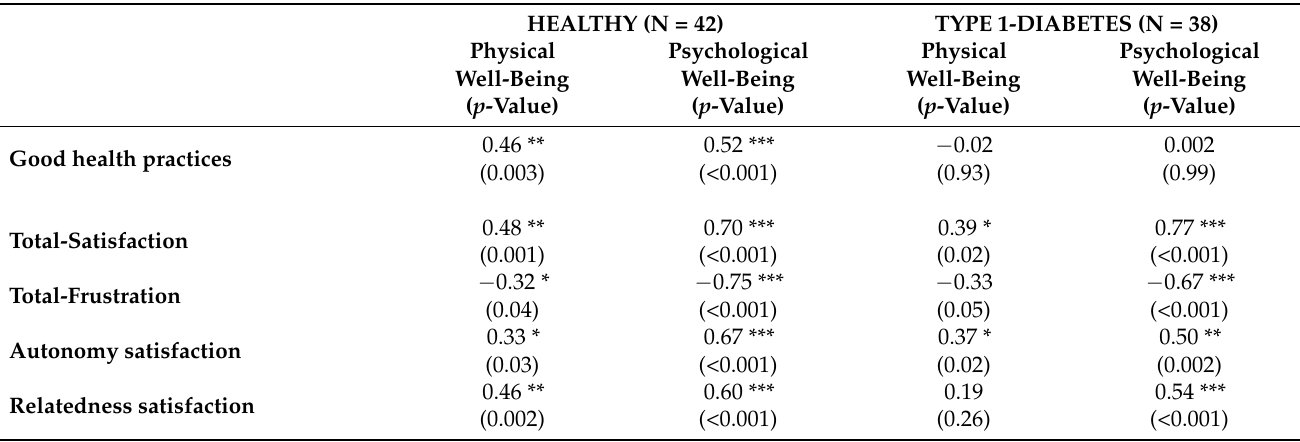
Table 4. Correlations between the independent (good health practices), the mediating (Satisfaction and frustration of basic psychological needs) and the dependent (physical and psychological well- being) variables according to the moderating variable (research